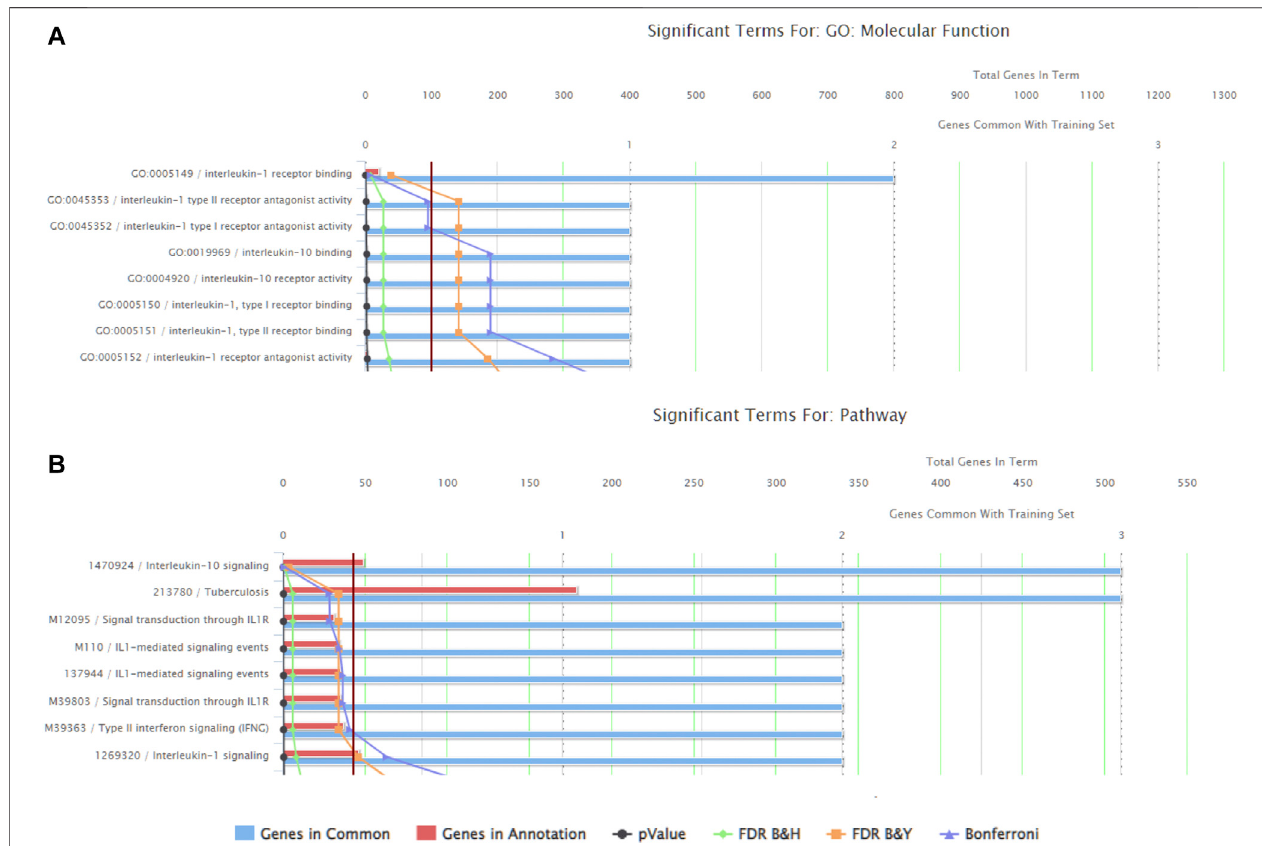
FIGURE 3 | ToppFun functional enrichment analysis of the 25 most upregulated genes. (A) Top fi ve molecular functions that are affected by the genes input in the system.Threeofthe fi vecategoriesareIL-1 β related,indicatedthatthisgeneisplayingaroleinthemolecularfunctionsbeingaltered withatrophy. (B) Pathwaysthatare signi fi cantly affect with the disuse model by the genes input in the system. Three of the fi ve pathways are again related to IL-1 receptor signaling. Together this data suggests the importance of IL-1 β .